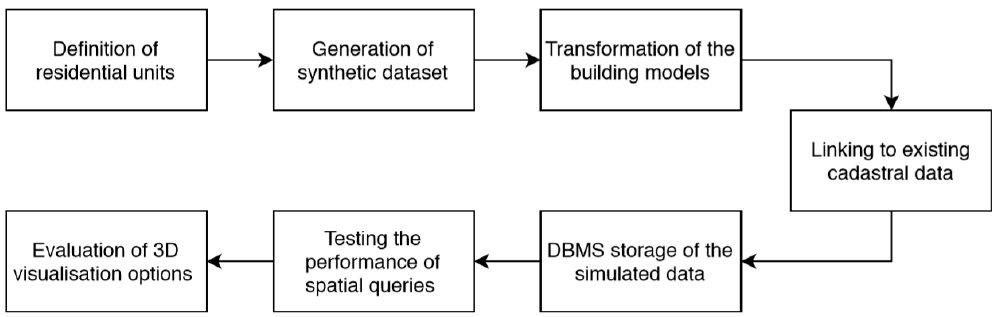
Figure 1. Study concept framework.